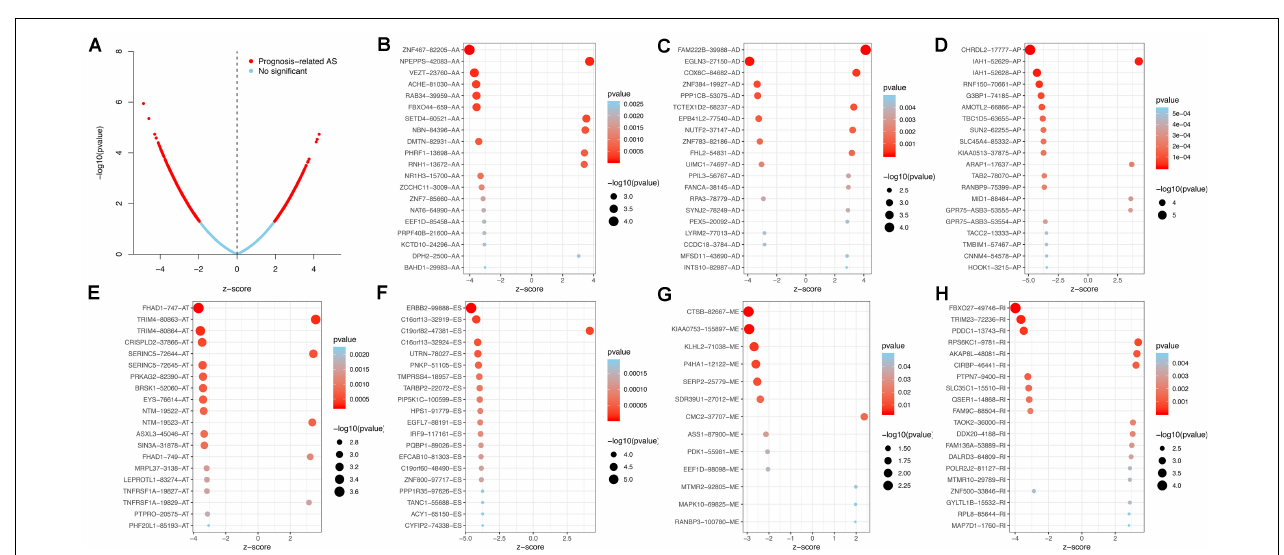
FIGURE 3 | Top 20 most significant AS events in ESCA. (A) The volcano plots of prognosis-connected AS events. The top 20 AS events associated with survival outcome for ESCA in different splice patterns, including (B) AA, alternate acceptor site. (C) AD, alternate donor site. (D) AP, alternate promoter. (E) AT, alternate terminator. (F) ES, exon skip. (G) ME, mutually exclusive exons. (H) RI, retained